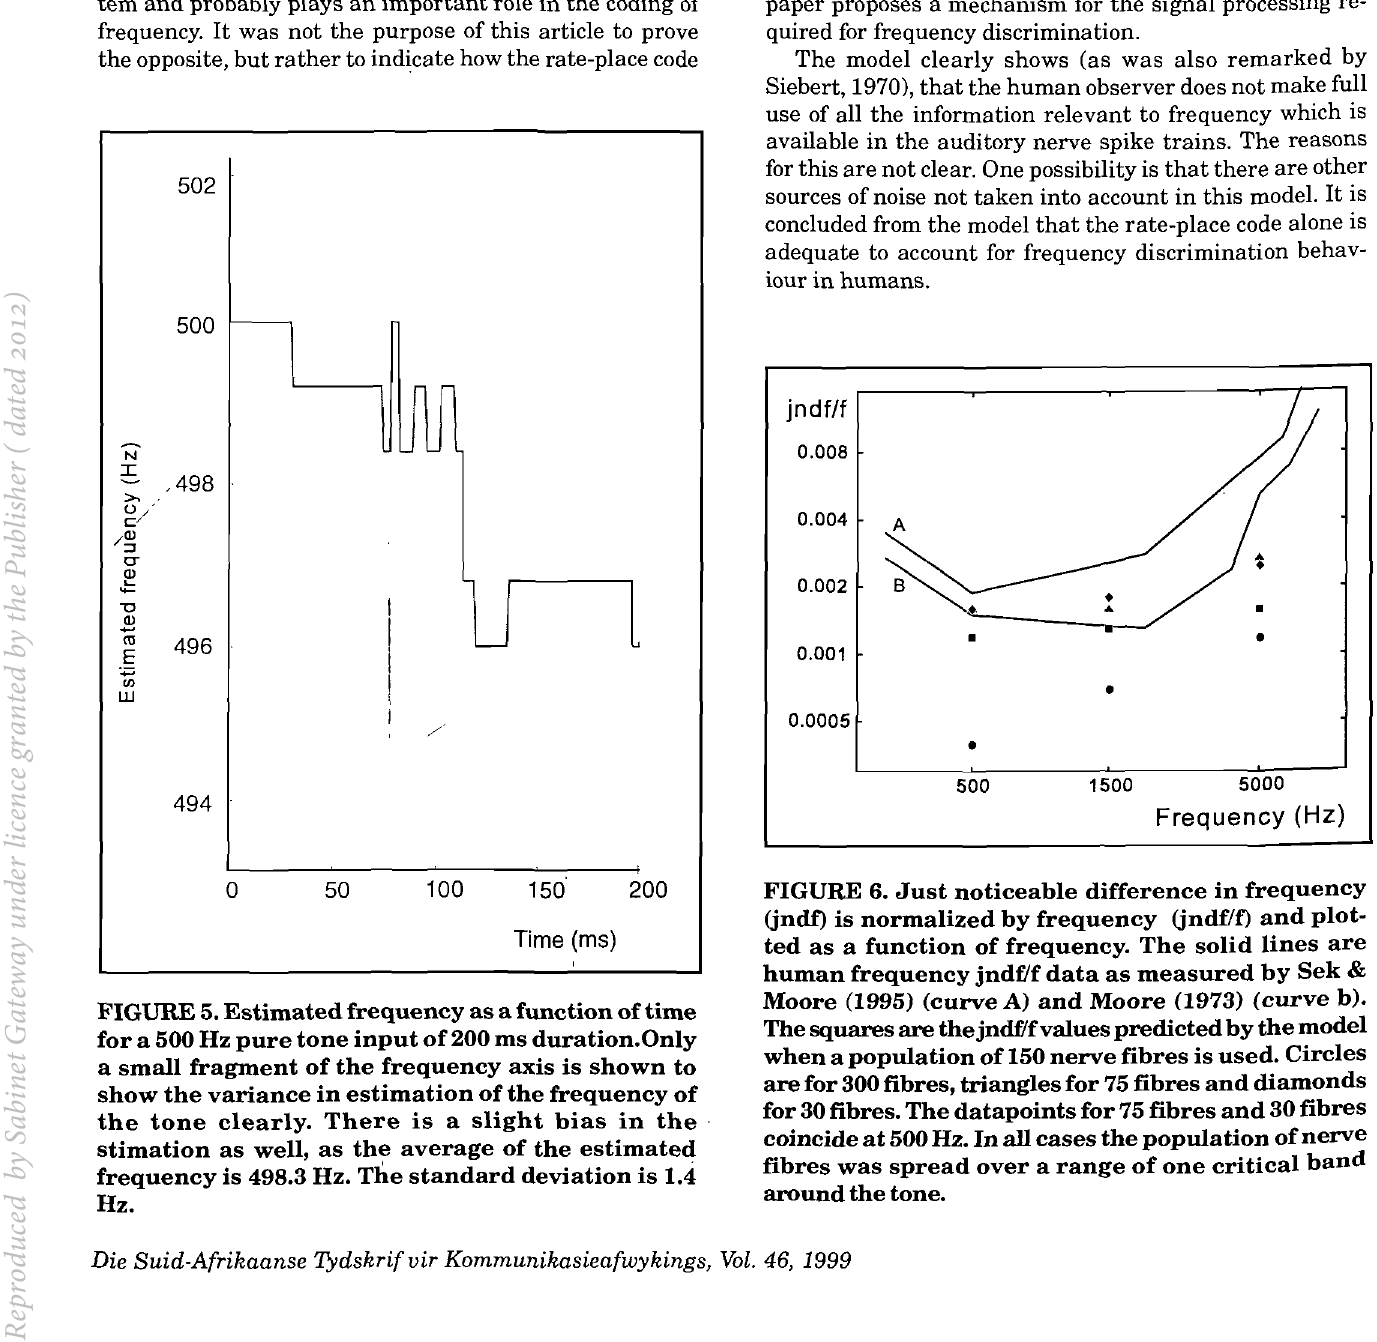
FIGURE 5. Estimated frequency as a function oftime for a 500 Hz pure tone input of 200 ms duration. Only a small fragment of the frequency axis is shown to show the variance in estimation of the frequency of the tone clearly. There is a slight bias in the . stimation as well, as the average of the estimated frequency is 498.3 Hz. The standard deviation is 1.4 Hz.